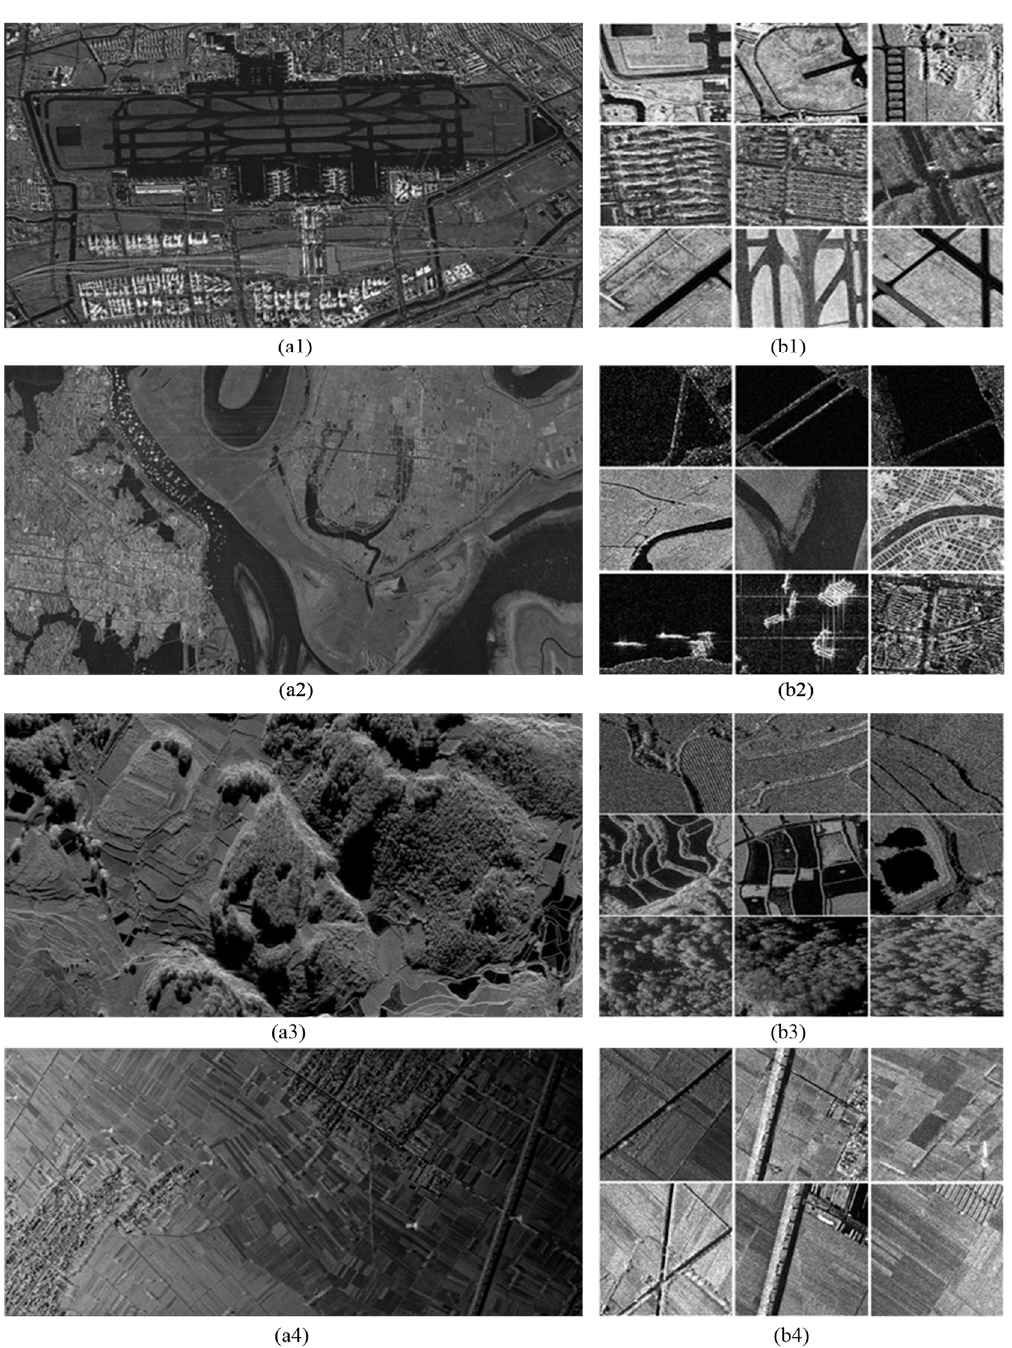
Figure 4. SAR images and samples: ( a1 – a4 ) SAR images used in the paper; ( b1 – b4 ) The scene samples extracted from left SAR images.